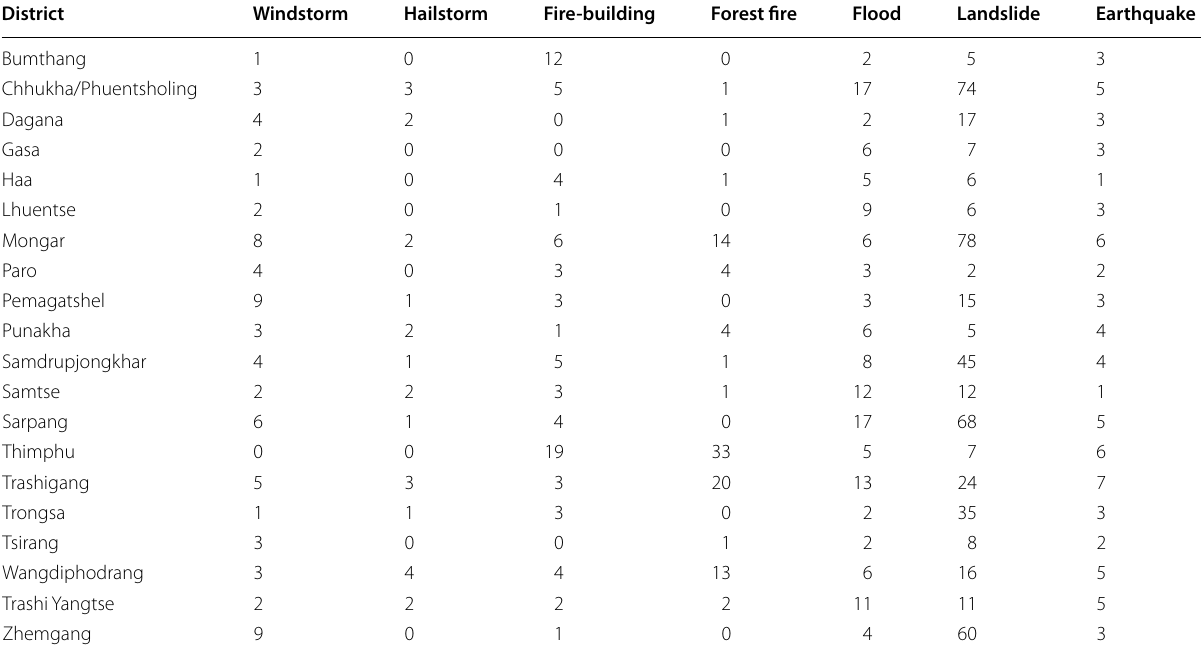
Table 2 Summary of number of hazard events in 20 districts of Bhutan